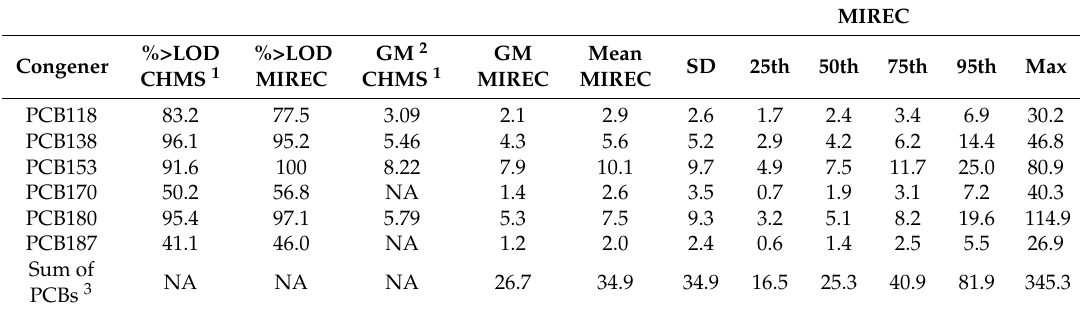
Table 2. Distributions of Blood Plasma PCBs (ng/g lipid) during the first trimester for MIREC study participants, Canada, 2008–2011 (n =